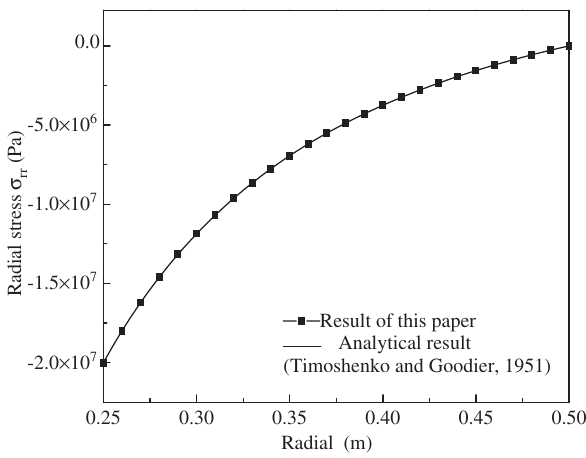
compared to analytical rr